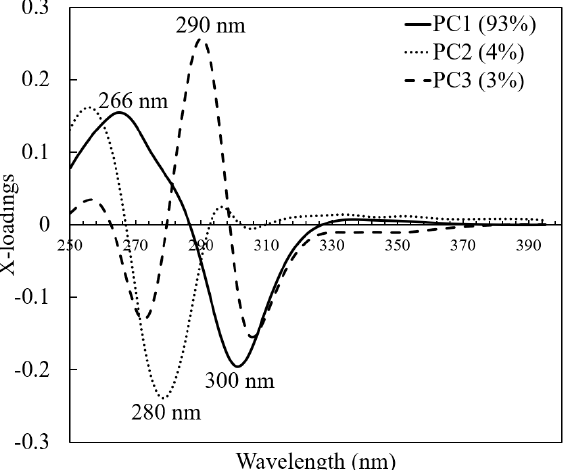
Figure 5. X-loadings plots for all three components for pre − processed spectra.